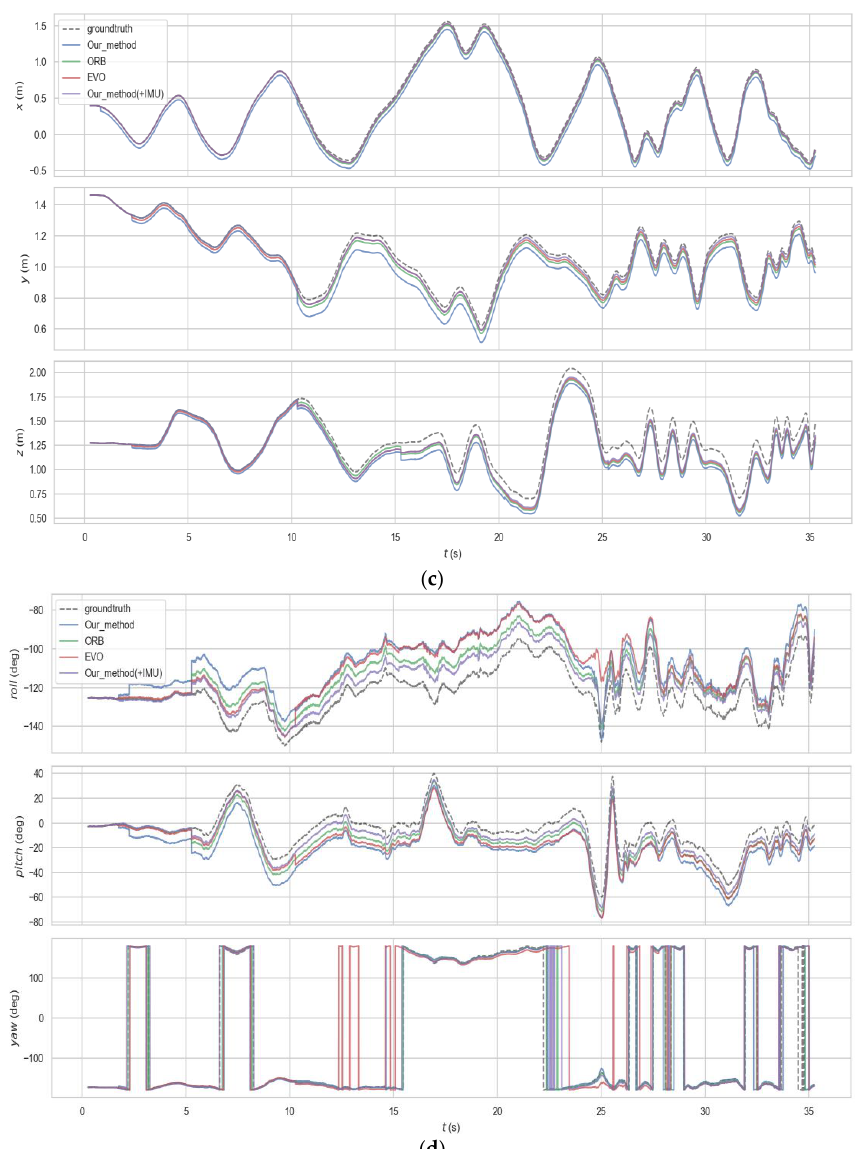
Figure 5. VO Experiment 1 (shapes_6dof): ( a ) 3D event camera trajectories estimated by different algorithms; ( b ) Comparison of absolute pose errors between different algorithms; ( c ) The translation position of the camera estimated by different algorithms; ( d ) The rotation position of the camera estimated by different algorithms.